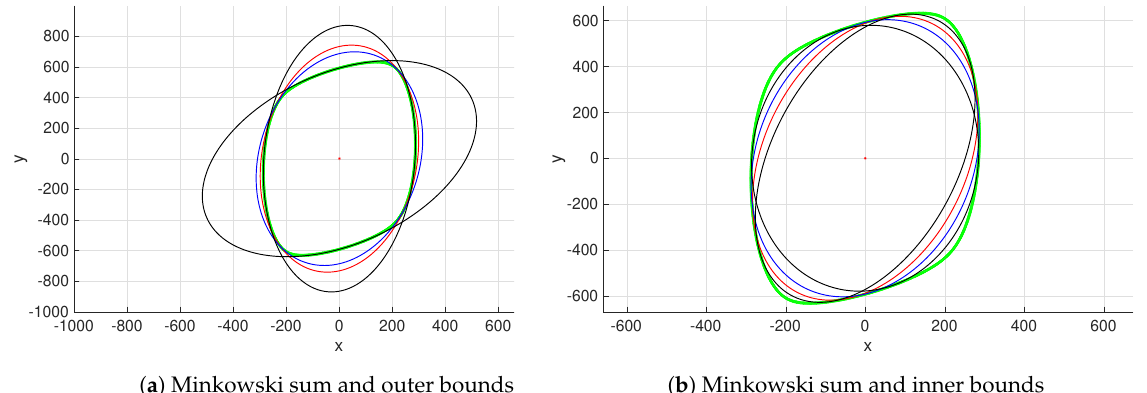
Figure 1. Green: Minkowski sum, red: Kurzhanski’s outer for β = 1 in subplot ( a ) and Kurzhanski’s inner for S 1 = I in subplot ( b ), blue: MVOE in subplot ( a ) and John’s inner in subplot ( b ) and black: Kurzhanski’s outer for β = λ 1/2 , λ 1/2 max in subplot ( a ) and also Kurzhanski’s inner for two arbitrary min nonidentity matrices of S 1 ∈ S + ( n , R ) in subplot ( b